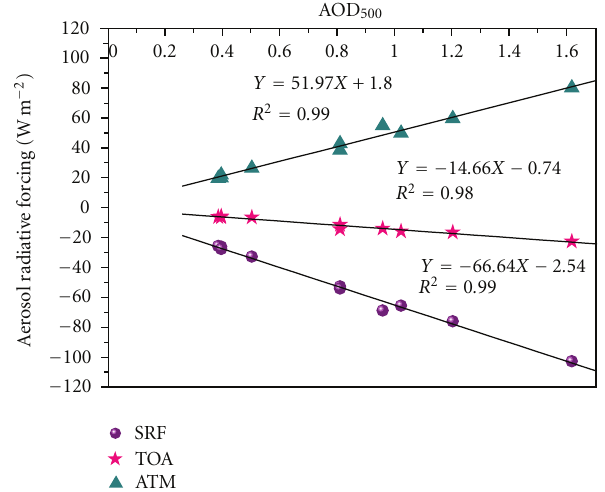
Figure 11: Correlation between AOD 500 with ARF values at TOA, SRF and ATM. The slope of the regressions defines the radiative forcing e ffi